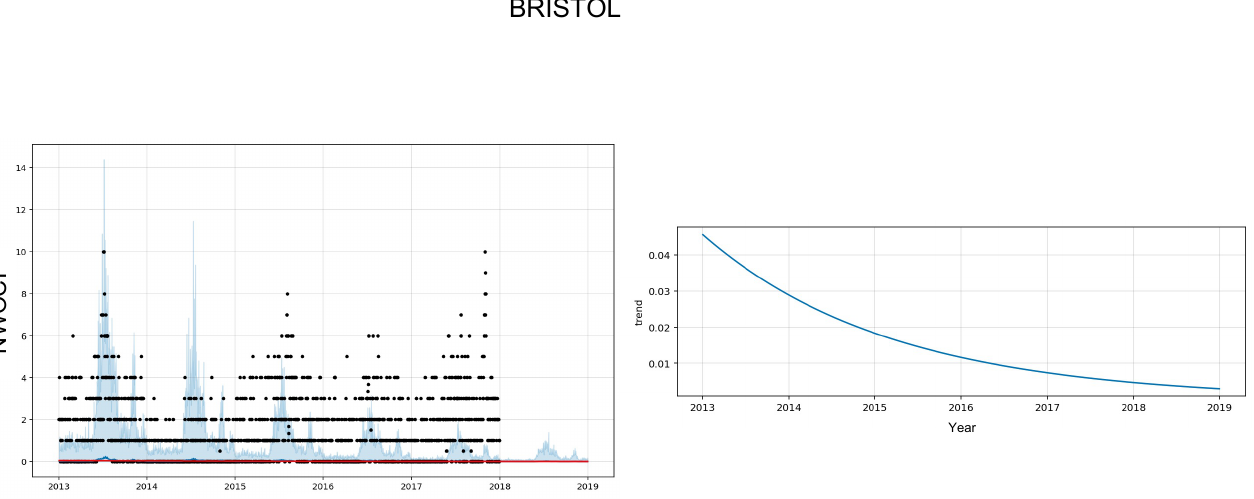
Figure A2. Left : One year forecast (2018 test data) from Prophet-BU Model for Berkshire county in MA. N.B: The solid blue line shows the average forecast while the solid red line shows the observed trend of NWOCI and the light blue region represents the 80% confidence interval for the forecast uncertainty. Also, the scatter points represent the historical values in the training data (2013–2017). Right : Trend decomposition from Prophet-BU Model for Berkshire county in MA.